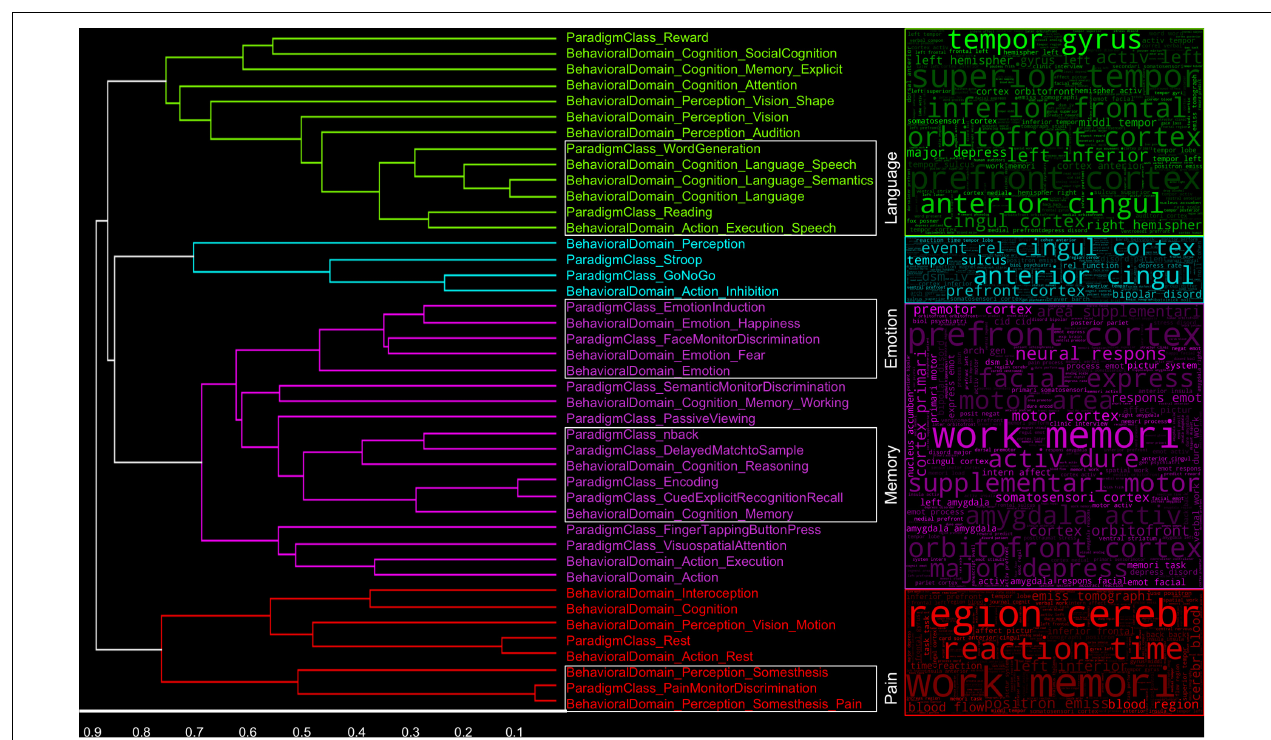
FIGURE 3 | Label similarity dendrogram. Similarity between Behavioral Domain and Paradigm Class metadata labels based on features selected for classification across folds and iterations. Clusters are representative of labels and their corresponding manuscript in which similar language was used throughout the whole text. The associated “word clouds” were generated by using the top 10% of the most frequently used bag-of-words features across labels and iterations in each